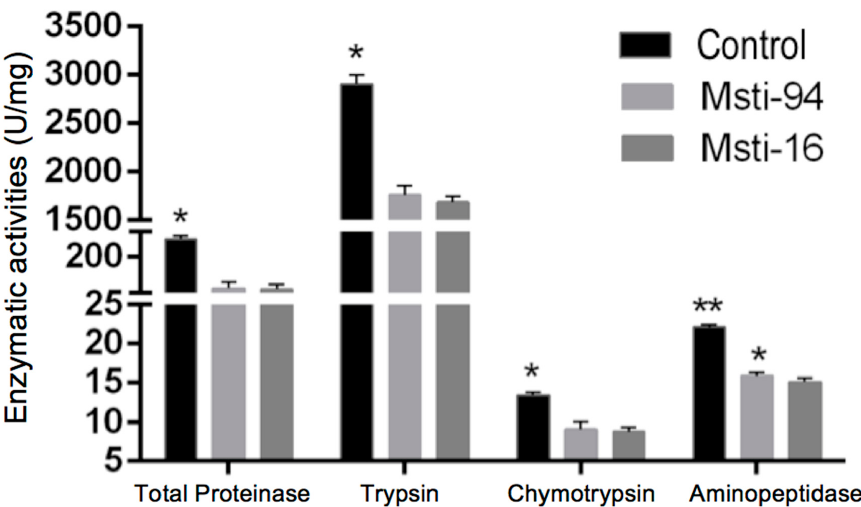
Figure 8. Enzyme activities of the four protease in aphids treated with Msti along with the control. Msti-94 / Msti-16 : the recombinant purified protein of Msti at a concentration of 800 μ g/mL was used to feed the aphids. Control: the artificial feed was used to feed the aphids. *, ** represents the level of significance at 5% and 10%, respectively.